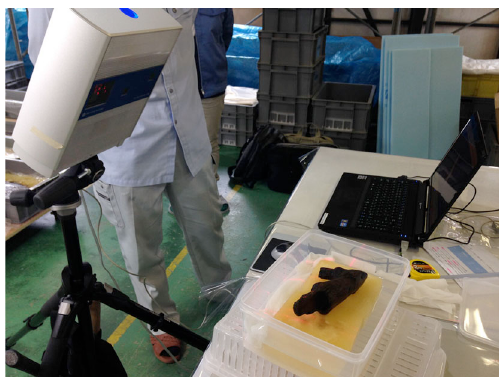
Figure 12. Measurement of a wooden relic by the